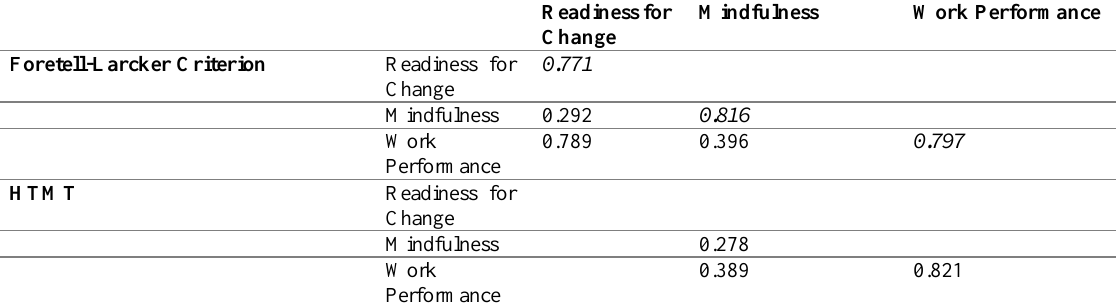
Table 2: Discriminant